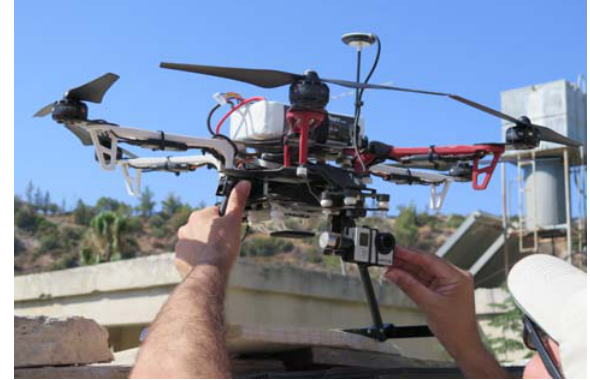
Figure 4. F550 hexacopter with attached GoPro camera